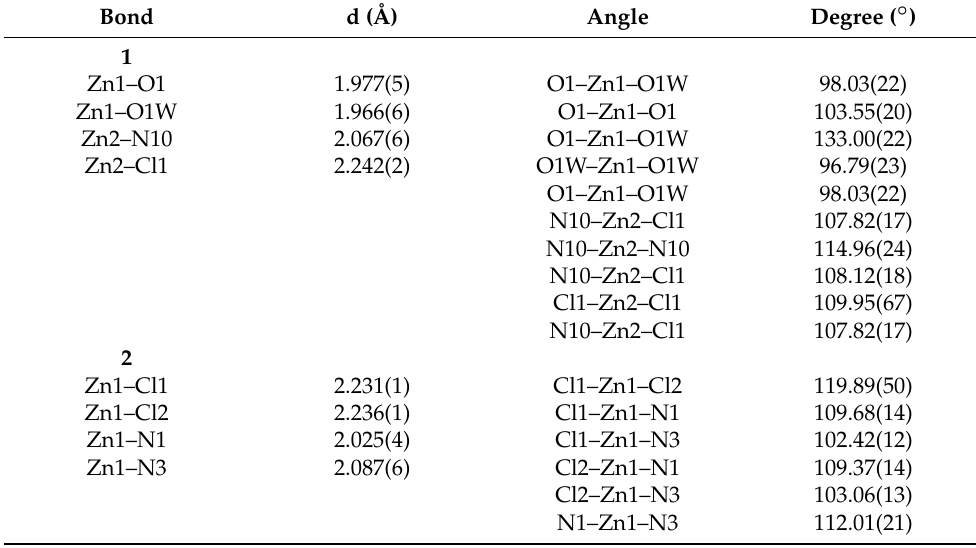
Table 2. Selected bond lengths (Å) and bond angles (deg.) of Zn(II) centers in 1 and 2 .